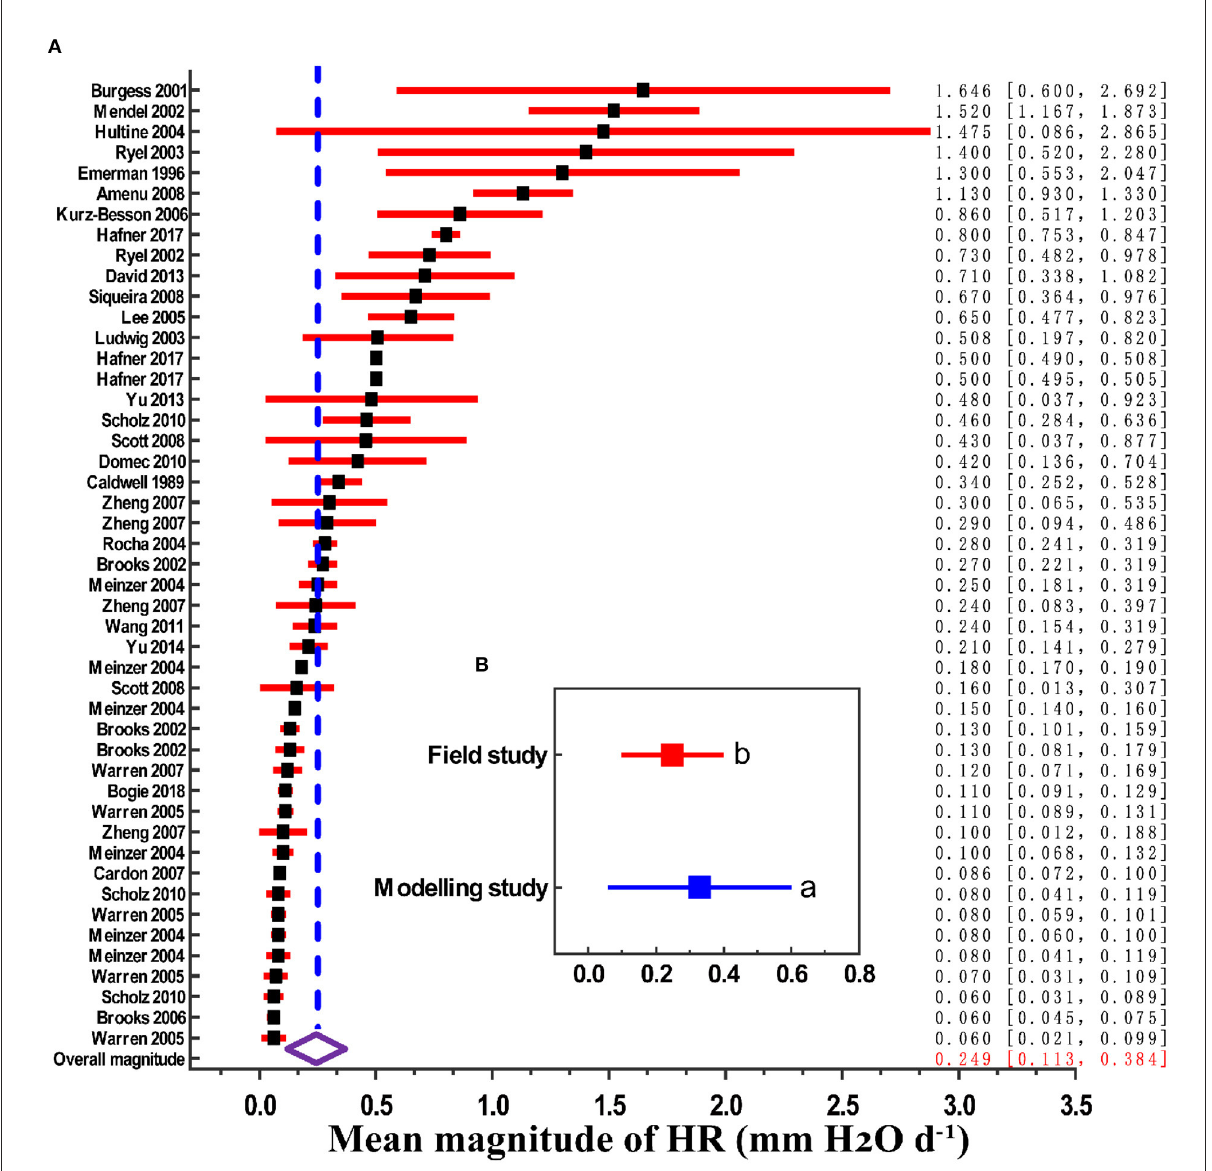
FIGURE1 Mean magnitude of HR (x-axis: 0 corresponds to no HR; > 0 corresponds to the actual measured mean amount of HR). (A) Magnitude estimates grouped by source paper (first author-year format). Filled black squares are magnitude point estimates, error bars are 95% CI (red horizontal lines). The open diamond represents the overall magnitude value, and its 95% CI is represented by the width of the diamond. (B) Magnitude estimates grouped by field study and modeling study; different lowercase letters indicate significant difference at the 0.05